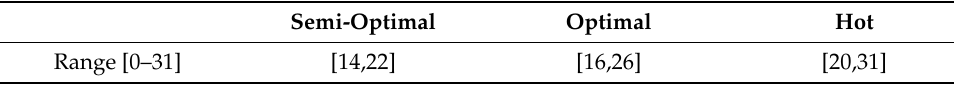
Table 2. Substrate temperatura fuzzy sets ( ◦ C).